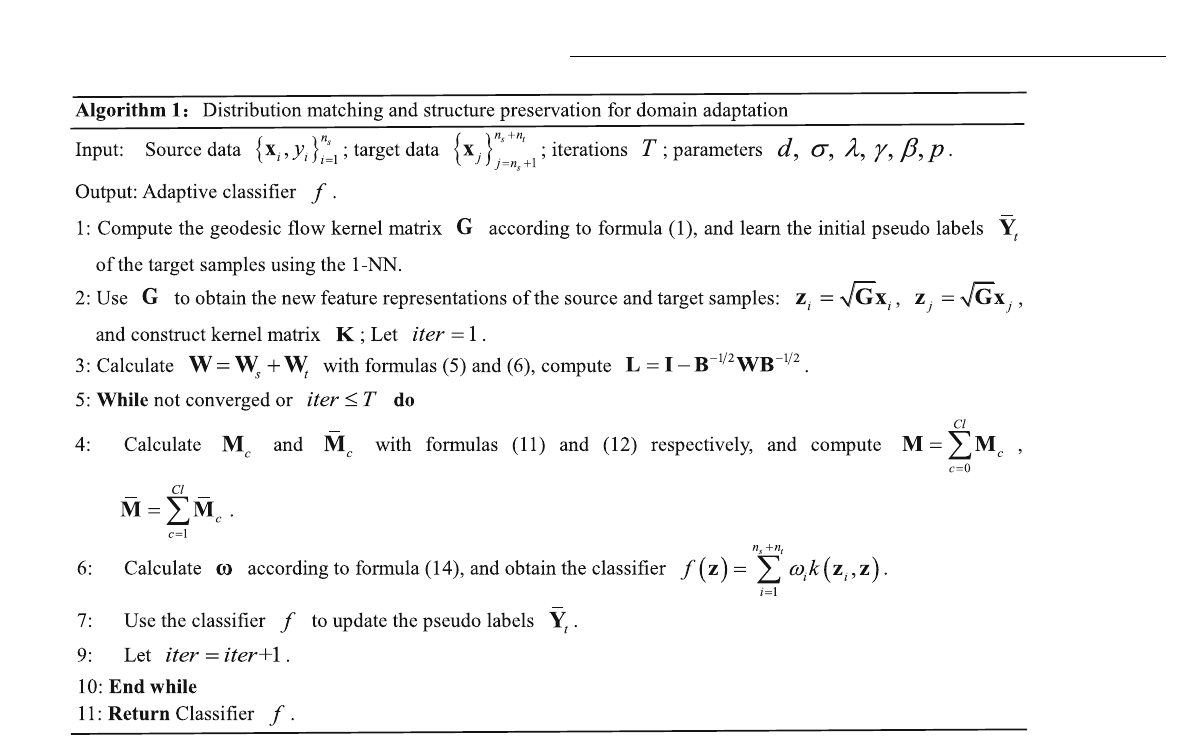
Fig. 2 Flow chart of